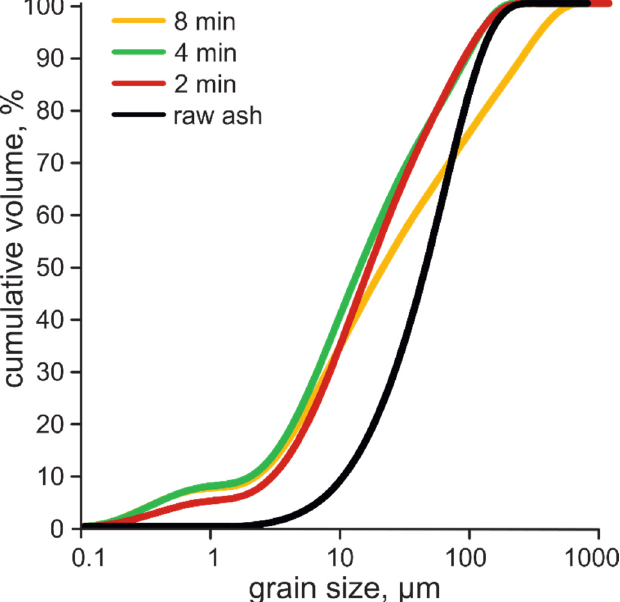
Figure 1. Cumulative grain size distribution of the raw and mechanically activated ash after milling for 2, 4, and 8 min.